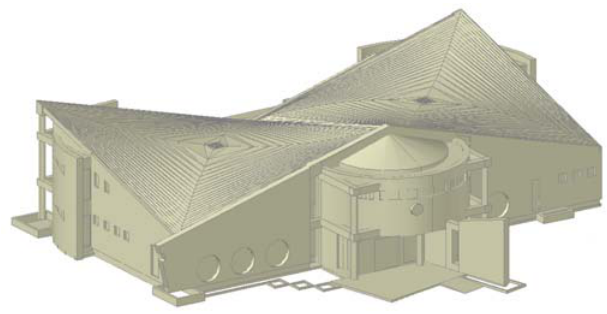
Figure 2. The 3D model, without texture, of the dean’s office